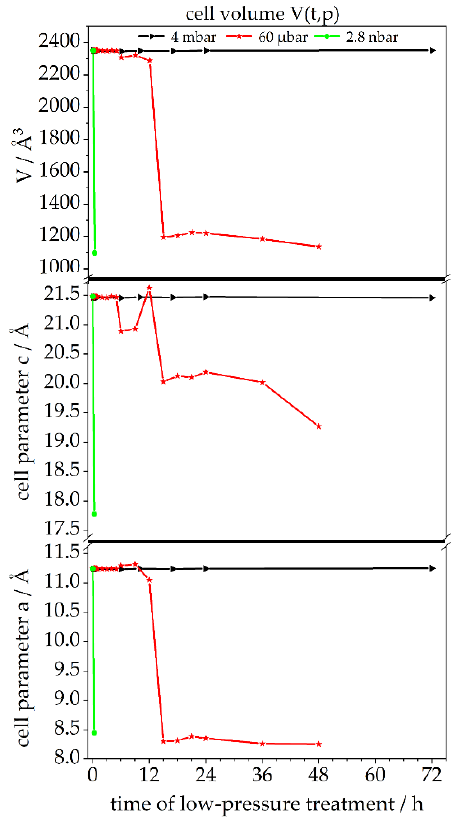
Figure 8. Cell parameters a and c and cell volume V derived from Pawley fits of powder XRD data; retrogression of the cell of synthetic ettringite after treatment at three different levels of low pressure (4 mbar: black; 60 µbar: red; 2.8 nbar: green) for various durations (up to 72 h).